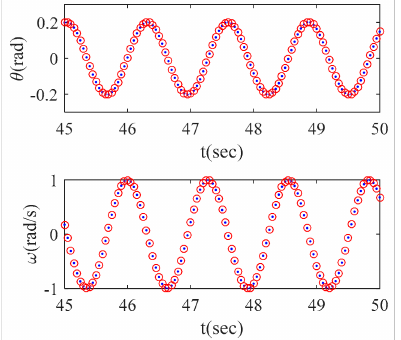
Figure 16. Two difference results of Lie algebra.